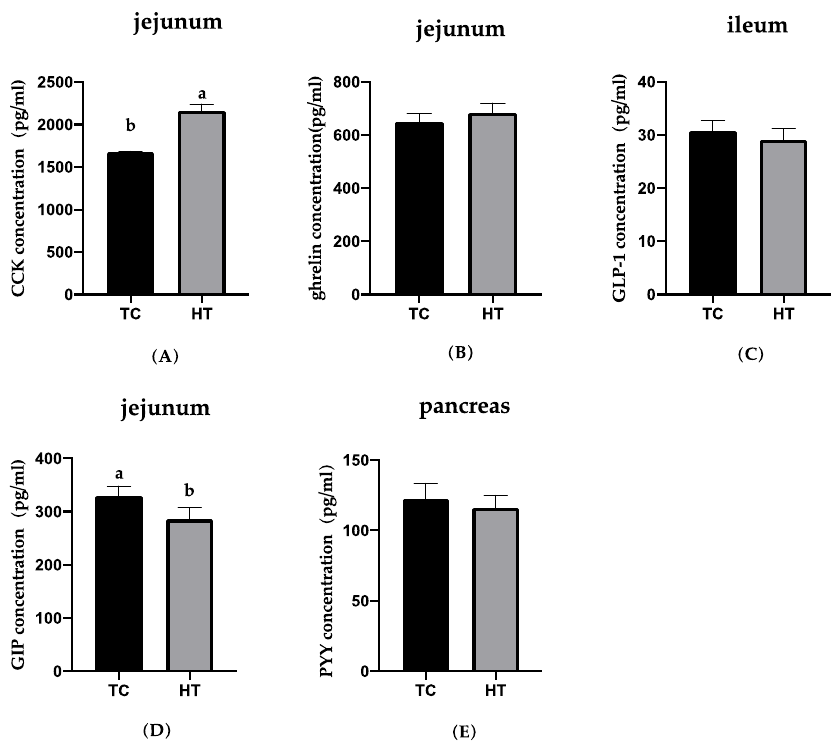
Figure 2. Effects of high temperature on concentrations of CCK, ghrelin, GIP in jejunum, GLP-1 in ileum and PYY in pancreas. ( A ), cholecystokinin; ( B ), ghrelin; ( C ), glucagon-like peptide-1; ( D ), glucose-dependent insulinotropic polypeptide; ( E ), peptide YY. a,b, Means with different letters within columns indicates significant differences ( p < 0.05).